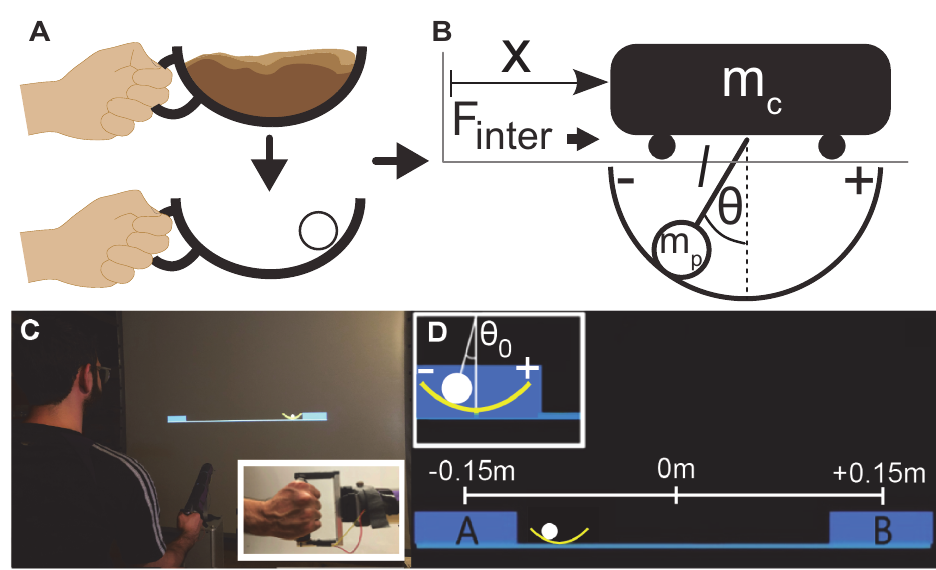
Fig 1. Task design and experimental setup : A. The task involved moving a two-dimensional cup with a ball sliding inside, inspired by humans carrying a cup of coffee. B. Mechanical model of a cart and pendulum. If the ball is at the bottom of the cup, the ball angle is defined as zero with positive and negative directions as shown. Hand movements that displace the cup on the horizontal line create interaction forces, F inter . C. The virtual experiment: A participant stands in front of the large screen and holds the handle of the HapticMaster robot to move the cup in the virtual environment. The inset shows the subject’s grip on the robot handle. D. Two rectangles on the screen delimited the cup movement amplitude, although they were larger than the cup allowing for some tolerance to downplay accuracy demands. Box A and Box B were 0.30 m apart, located at -0.15 m and 0.15 m, respectively.